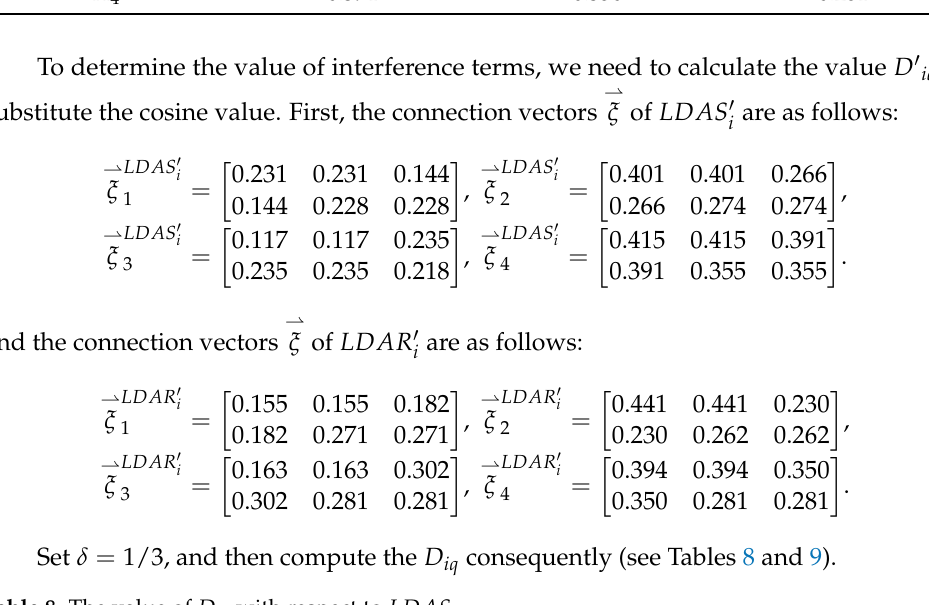
Table 8. The value of D iq with respect to LDAS i .